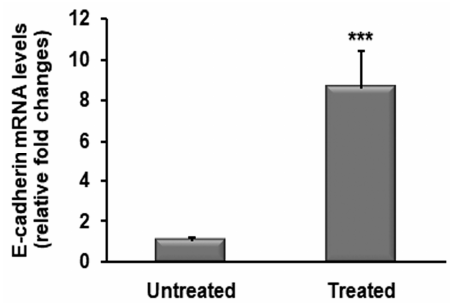
Figure 5. Analysis of expression levels of E-cadherin in foreskins from BXO patients untreated ( n = 15) or treated ( n = 15) with OZOILE ® . Results obtained by real-time PCR are expressed as relative fold change compared with untreated patients. Error bars represent standard error of the mean. *** p <0.001 significant differences in comparison with untreated patients.